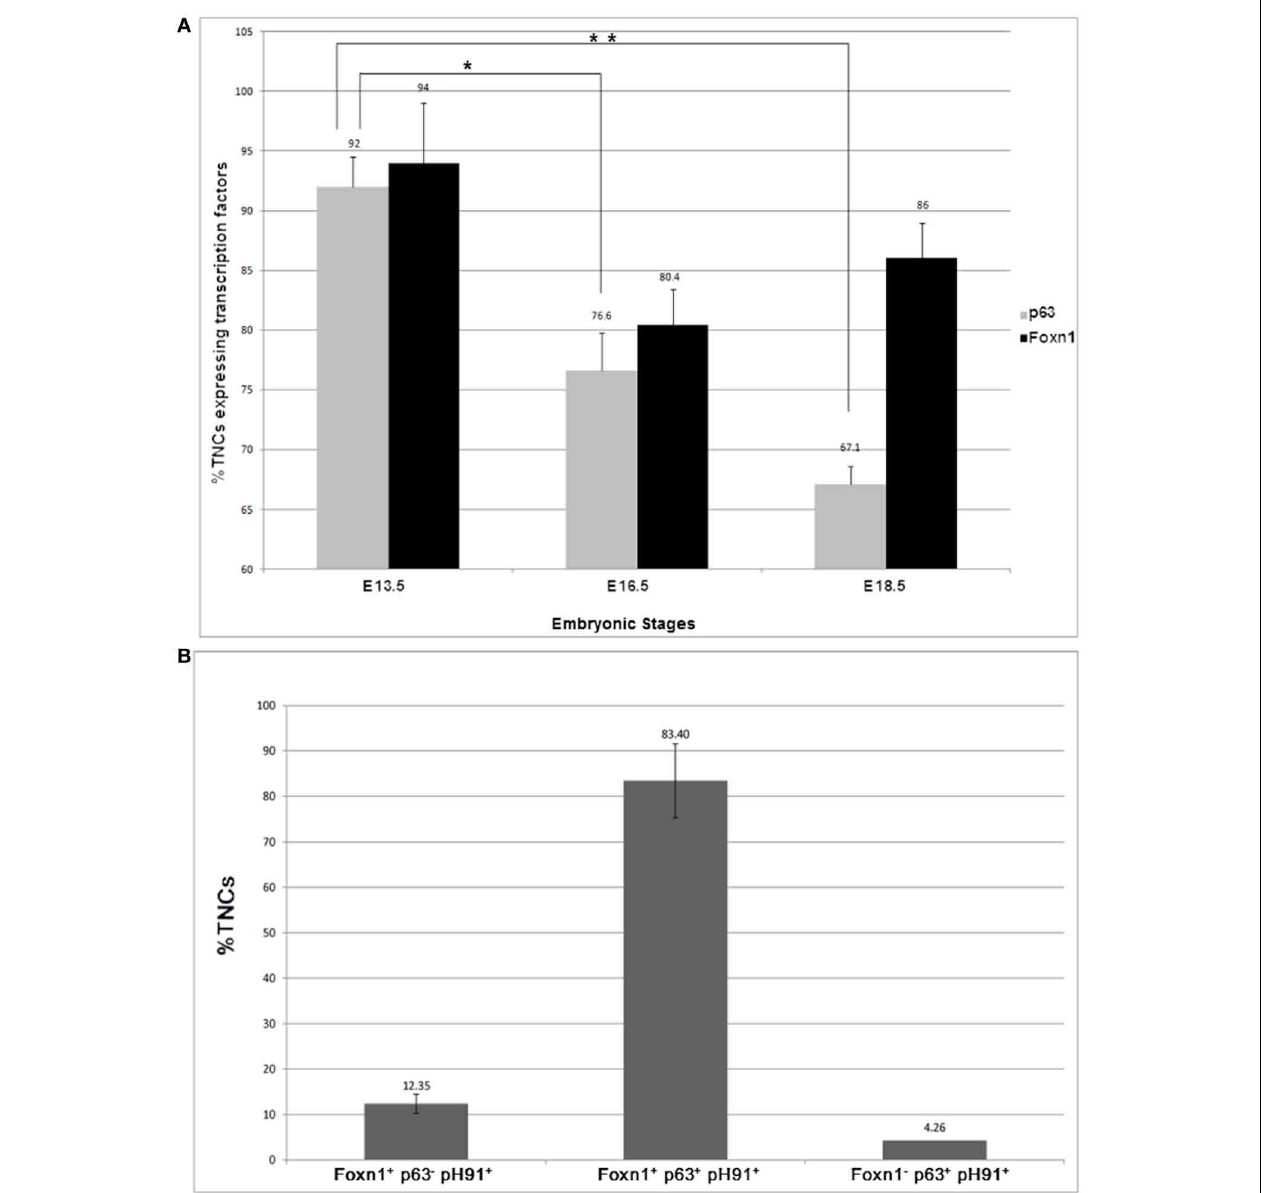
FIGURE 6 | Quantification of pH91 + multicellular TNCs expressing the transcription factors Foxn1 and p63. pH91 + multicellular TNCs were isolated from, thymi from C57BL/6 mice at embryonic stages of development E13.5, E16.5, and E18.5, cyto-spun onto slide and quantified manually with respect to expression of Foxn1, p63 and pH91. (A) shows the embryonic